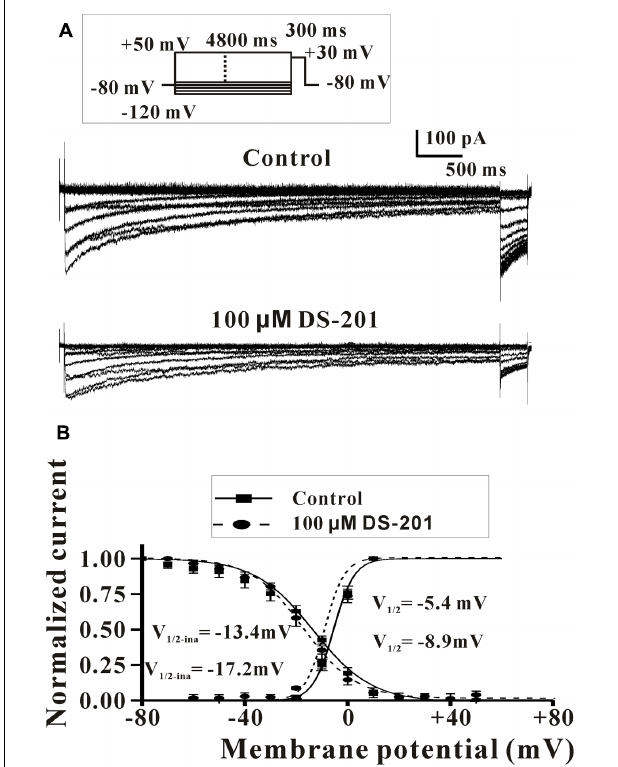
FIGURE 7 | Effect of DS-201 on the activation and inactivation of L-type Ca 2 + channel in L Ca channel-transfected HEK293 cells. (A) Typical recordings show that the activation and inactivation of L-type Ca 2 + channel under membrane potentials of − 100 to + 30 mV with or without DS-201 (100 µ M) treatment. (B) For the activation curve, I–V relations were obtained from the variables of normalized current ( I peak / I peak − max ) of I Ca , L and the relative stimulation voltage. For the inactivation curve, I–V relations were obtained from the variables of normalized current ( I peak / I peak − max ) of I Ca , L at tested potential of + 30 mV and the relative voltage of conditioning prepulses. I–V curves were fitted to the Boltzmann function: y = 1/(1 + exp ([V-V 1 / 2 )/k]), where V as the tested membrane potential, V 1 / 2 as the potential of half-maximal activation, and k as the slope factor. The data were obtained from three cells of three